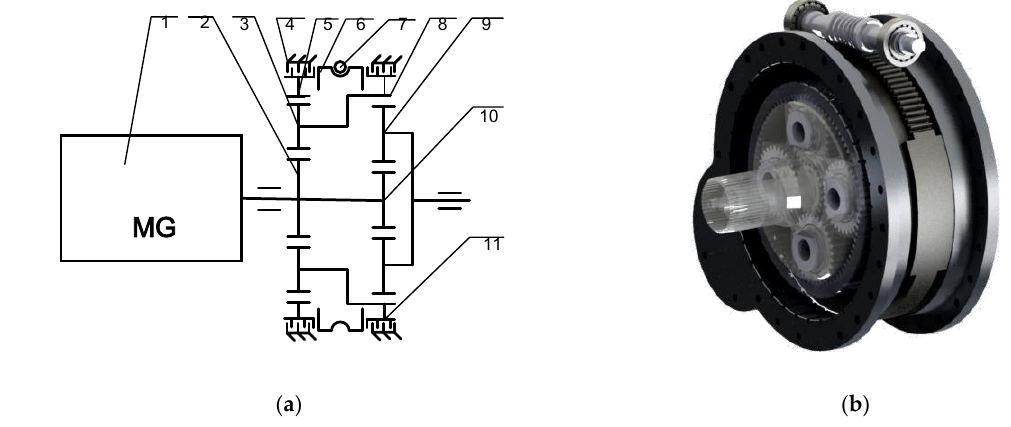
Figure 2. The layout of the transmission: ( a ) Schematic diagram; and ( b ) the designed transmission in SolidWorks ( MG, motor/generator; 1, drive motor; 2, 1st sun gear (S1); 3, 1st planet gear (C1); 4, 1st brake (B1); 5, 1st ring gear (R1); 6, worm shaft; 7, worm gear; 8, 2nd ring gear (R2); 9, 2nd planet gear (C2); 10, 2nd sun gear (S2); 11, 2nd brake (B2)). Table 2. Brake states for gear.